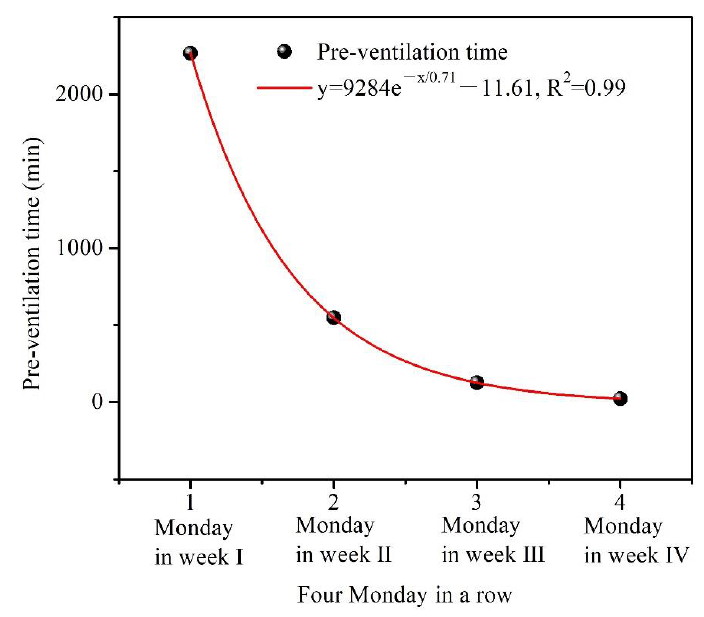
Figure 9. Pre-ventilation time for four consecutive Mondays.